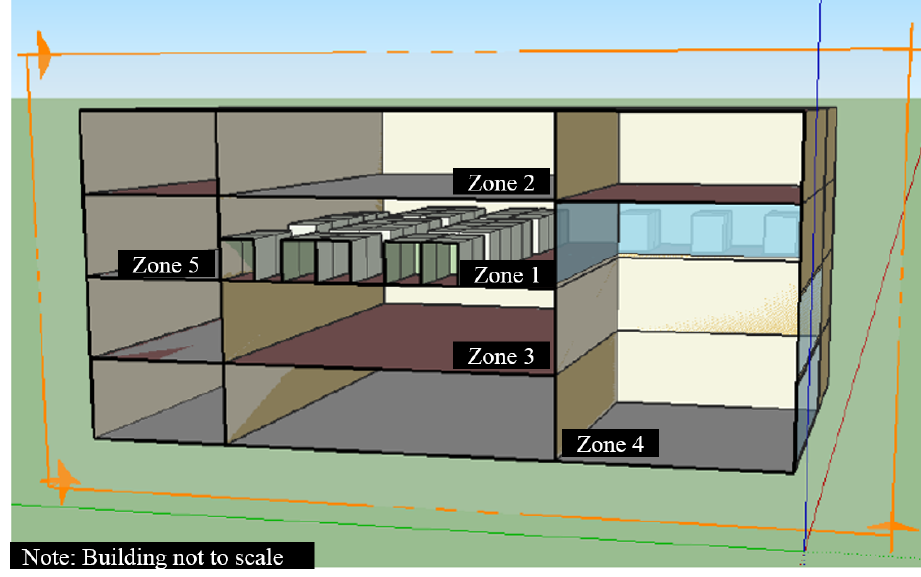
Figure 3. 3D model of our simulated office building zone in SketchUp. Zone 1 is the simulated zone, with Zones 2–5 acting as adjacent, ideal air